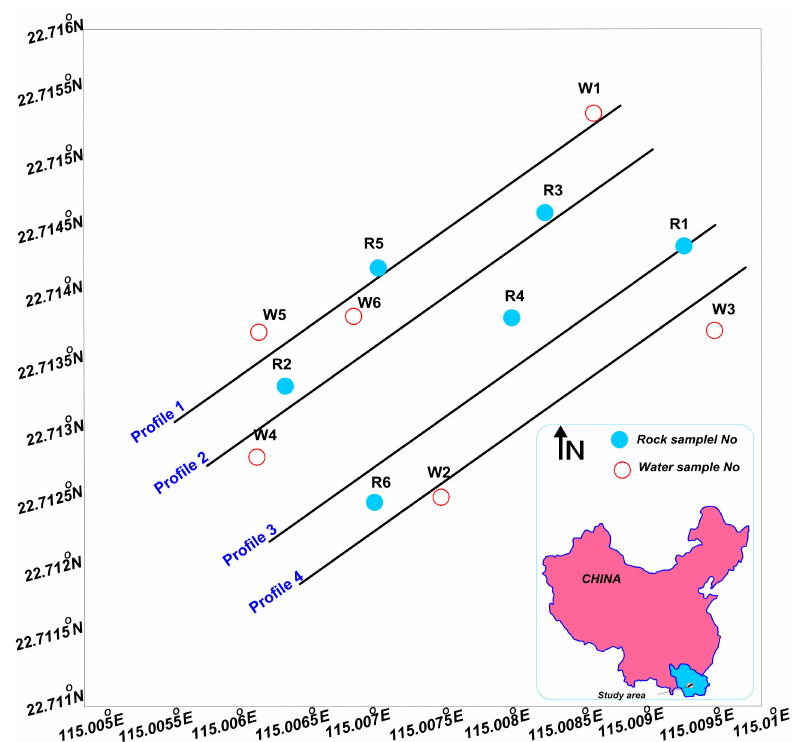
Figure 15. Map showing the locations of rock and water samples in the investigated